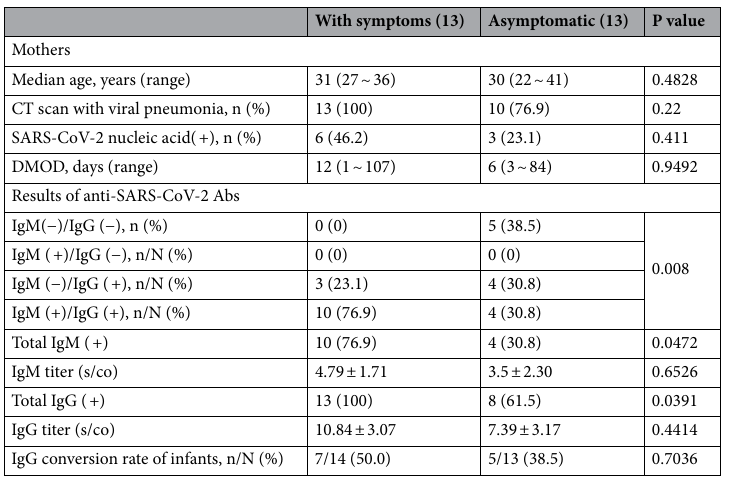
Table 2. Clinical characteristics of SARS-CoV-2 infected mothers with or without symptoms. DMOD days from mother’s onset to delivery, CT computed tomography.